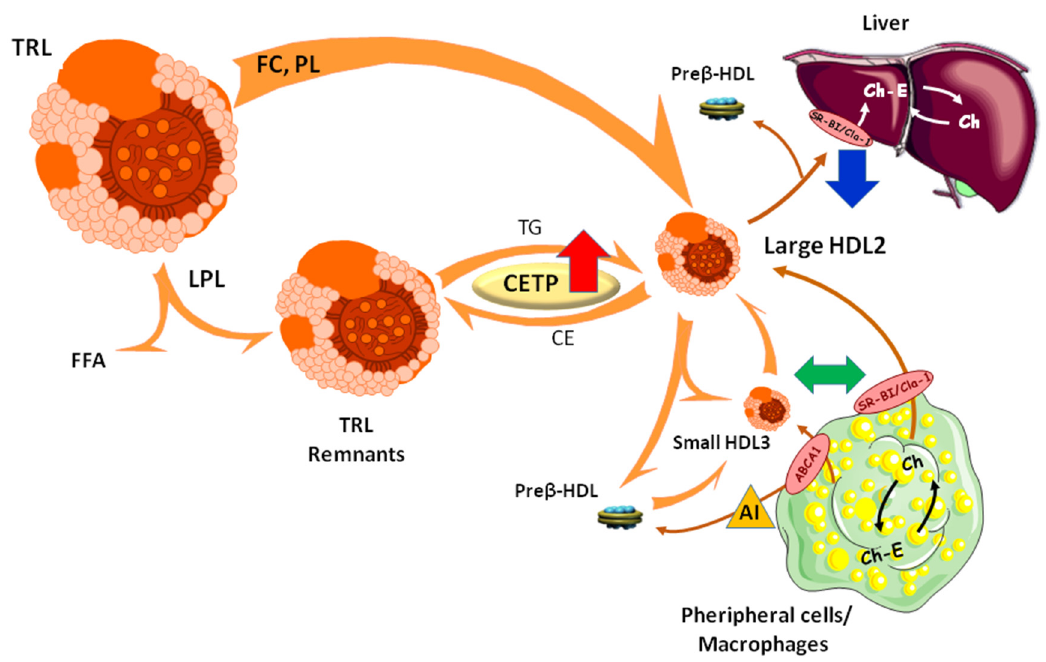
Figure 7. Schematic representation of the reverse cholesterol transport pathway and intravascular remodeling of lipoprotein particles during the postprandial phase. Large arrows indicate steps of the reverse cholesterol transport pathway that are enhanced (red arrow), reduced (blue arrow) or unchanged (green arrow) in normolipidemic male subjects exhibiting an undesirable postprandial TG response (G High ) compared to those displaying a desirable postprandial TG response (G Low ).